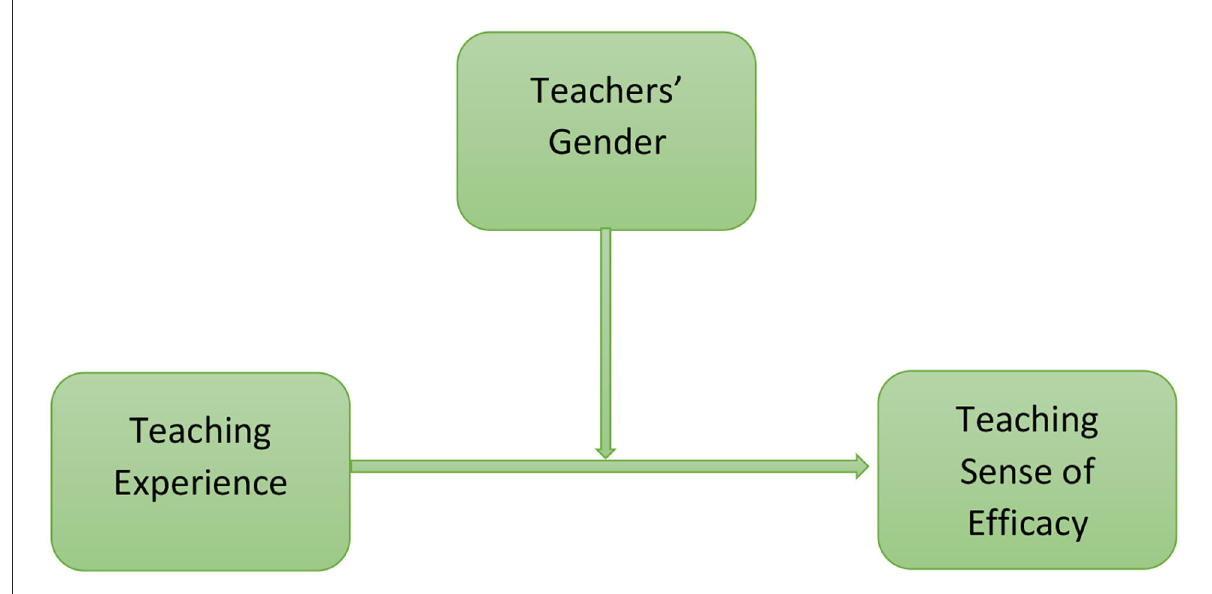
FIGURE1 A conceptual framework on the moderating role of gender in the link between teachers’ teaching experience and teaching sense of self-efficacy